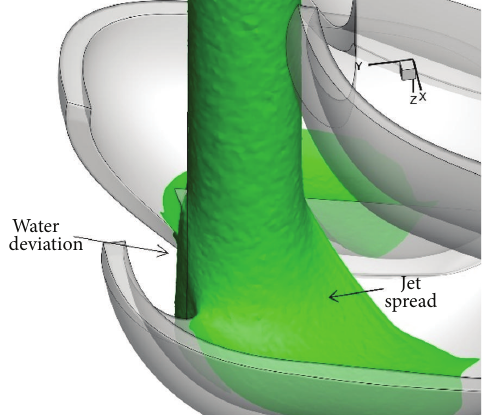
Figure 13: Water deviation close to the solid surface calculated with